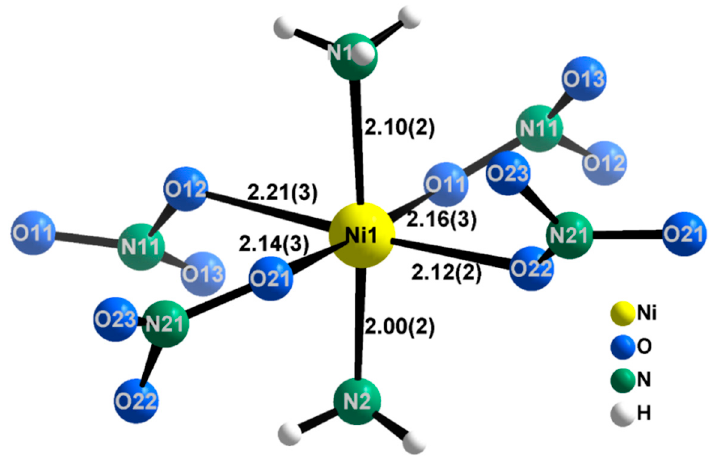
Figure 4. Coordination sphere around the nickel centre (Ni1) in the crystal structure of Ni(NH 3 ) 2 (NO 3 ) 2 . The Ni-ligand distances are given in Å. Ni (gold), N (green), and O (blue) atoms are represented by their displacement spheres at 90% probability, while H (white) atoms are given as generic balls.